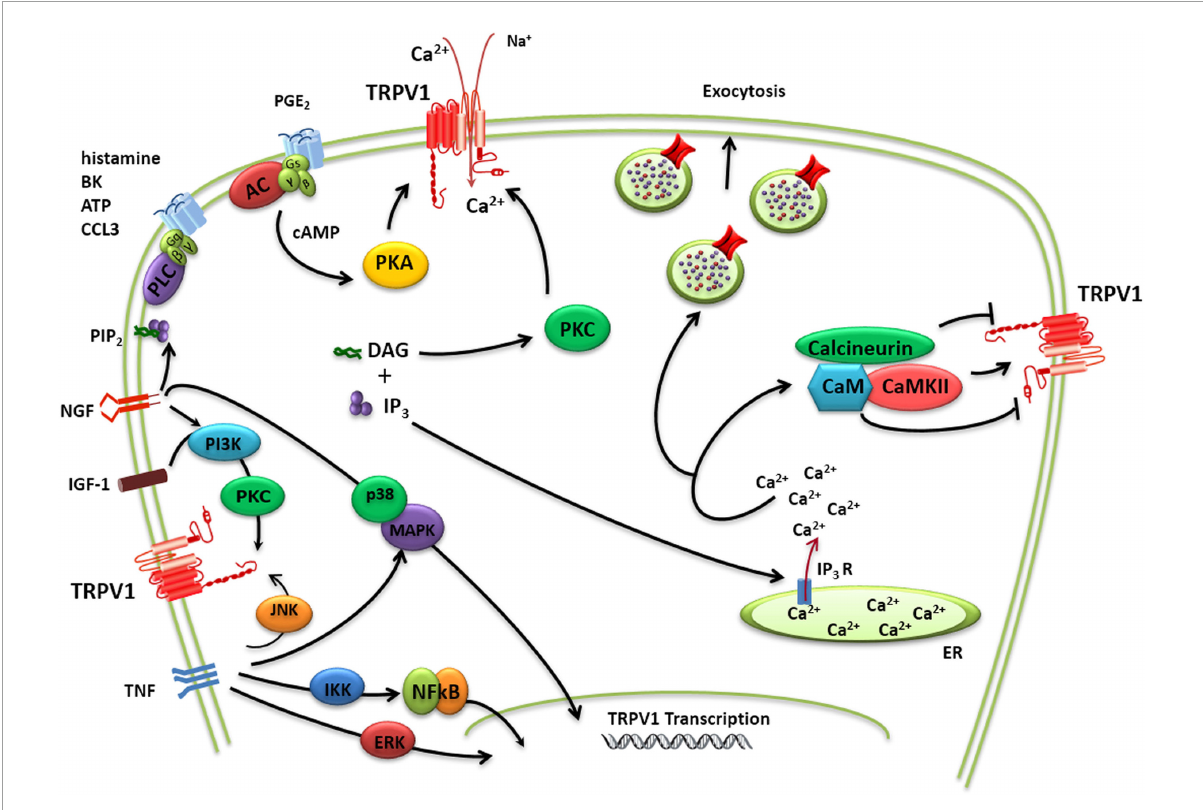
FIGURE2 TRPV1 modulation. Schematic diagram of complex regulation of TRPV1 implicated in pain transduction. TRPV1 channels may not only act as ligand-gated ion channels but may also increase neuron excitability through the activation of intracellular signaling pathways. The activity of TRPV1 is controlled by a multitude of regulatory mechanisms that either causes sensitization or desensitization of the channel. TRPV1 sensitization appears mediated by direct phosphorylation of intracellular protein domains by PKC, PKA, and other kinases. A dynamic balance between phosphorylation and dephosphorylation of TRPV1 by Ca 2 + /calmodulin-dependent kinase II and calcineurin, respectively, appears to control the activation/desensitization state of the channel. TRPV1 activity may be additionally potentiated by Ca 2 + -induced exocytotic recruitment to the cell membrane of an internal pool of vesicular